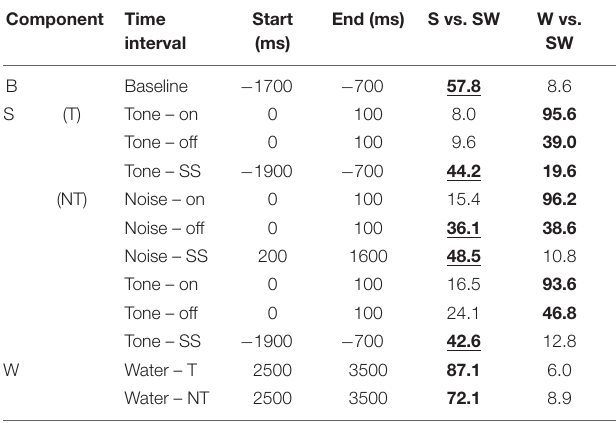
TABLE 3 | Median contrasts of the firing rates between experimental conditions of the passive monkeys. Component Time interval